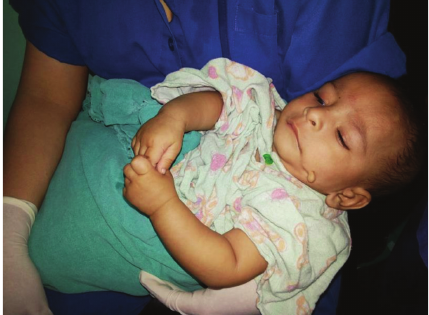
Figure 3: Child with preauricular tag and the skin tag in the